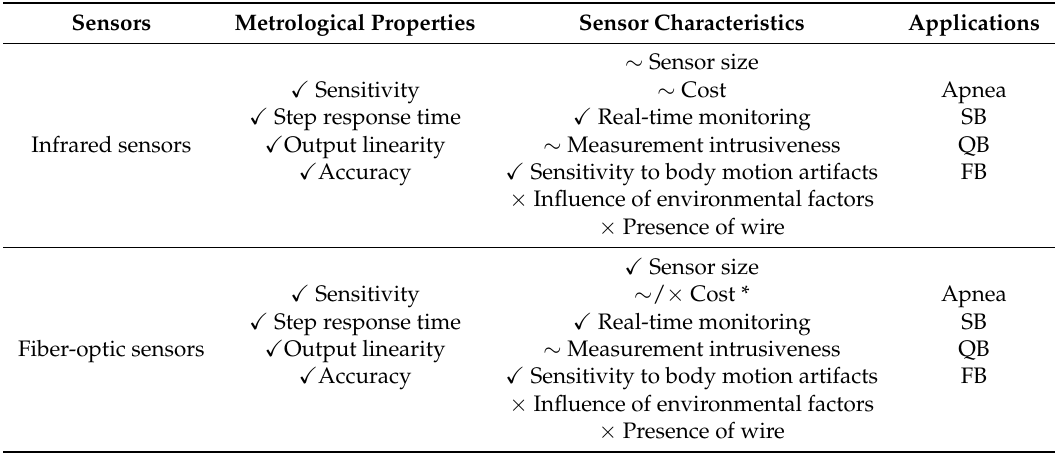
Table 5. Main metrological properties and characteristics of the air component sensors used for f R measurement. (cid:88) good to excellent, ∼ sufficient, ×